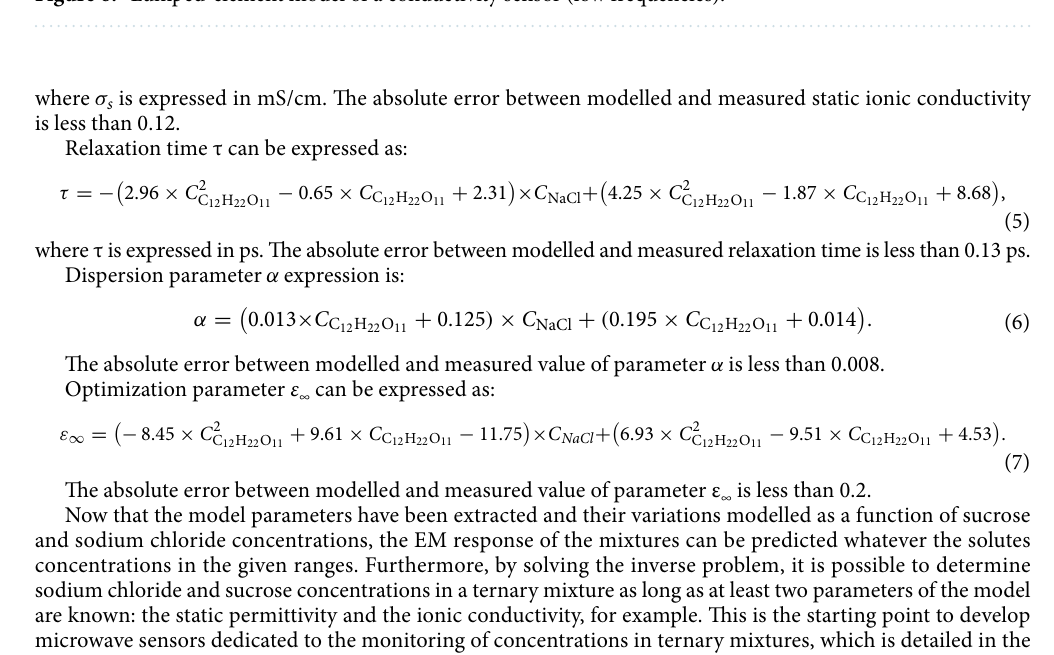
Figure 6. Lumped-element model of a conductivity sensor (low